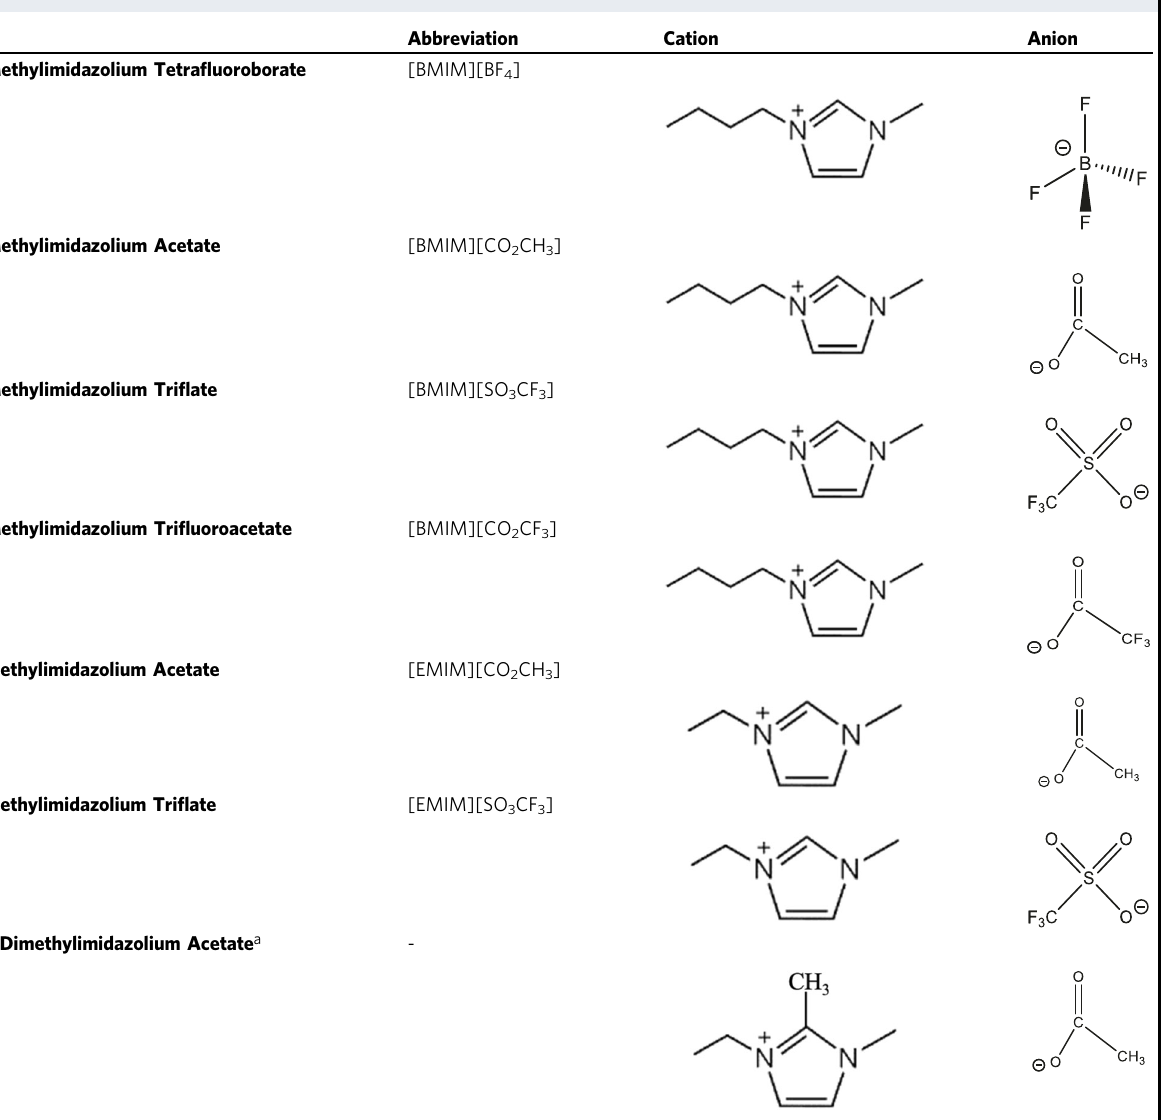
Table 1 Ionic liquids